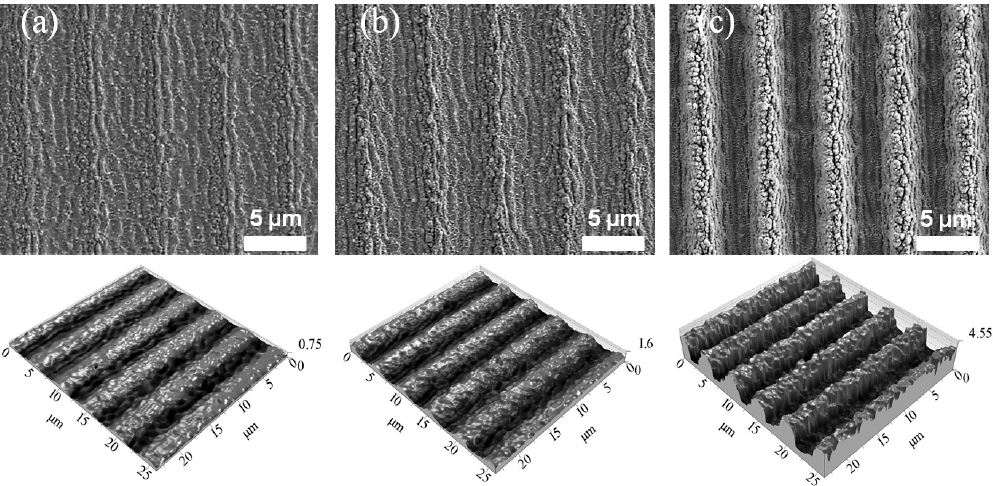
Figure 4. SEM (top row) and confocal (bottom row) microscopy micrographs of periodic structures on stainless steel fabricated with ( a ) 95%, ( b ) 97%, and ( c ) 99% overlap, and a spot diameter of 285 µm (0.56 J/cm²). The micrographs were taken in the center of the scanned path described in Figure 2. After laser patterning experiments, the mean depths, ℎ , of the fabricated structures were measured using confocal microscopy. The depth ℎ was measured in the center of the structured area (see Figure 1) and averaged across the area of 25 × 25 µm², which is the field of view of the utilized 150× objective. The three-dimensional scatter plot of the measured depths of all fabricated structures is depicted in Figure 5a as black dots with drop lines.